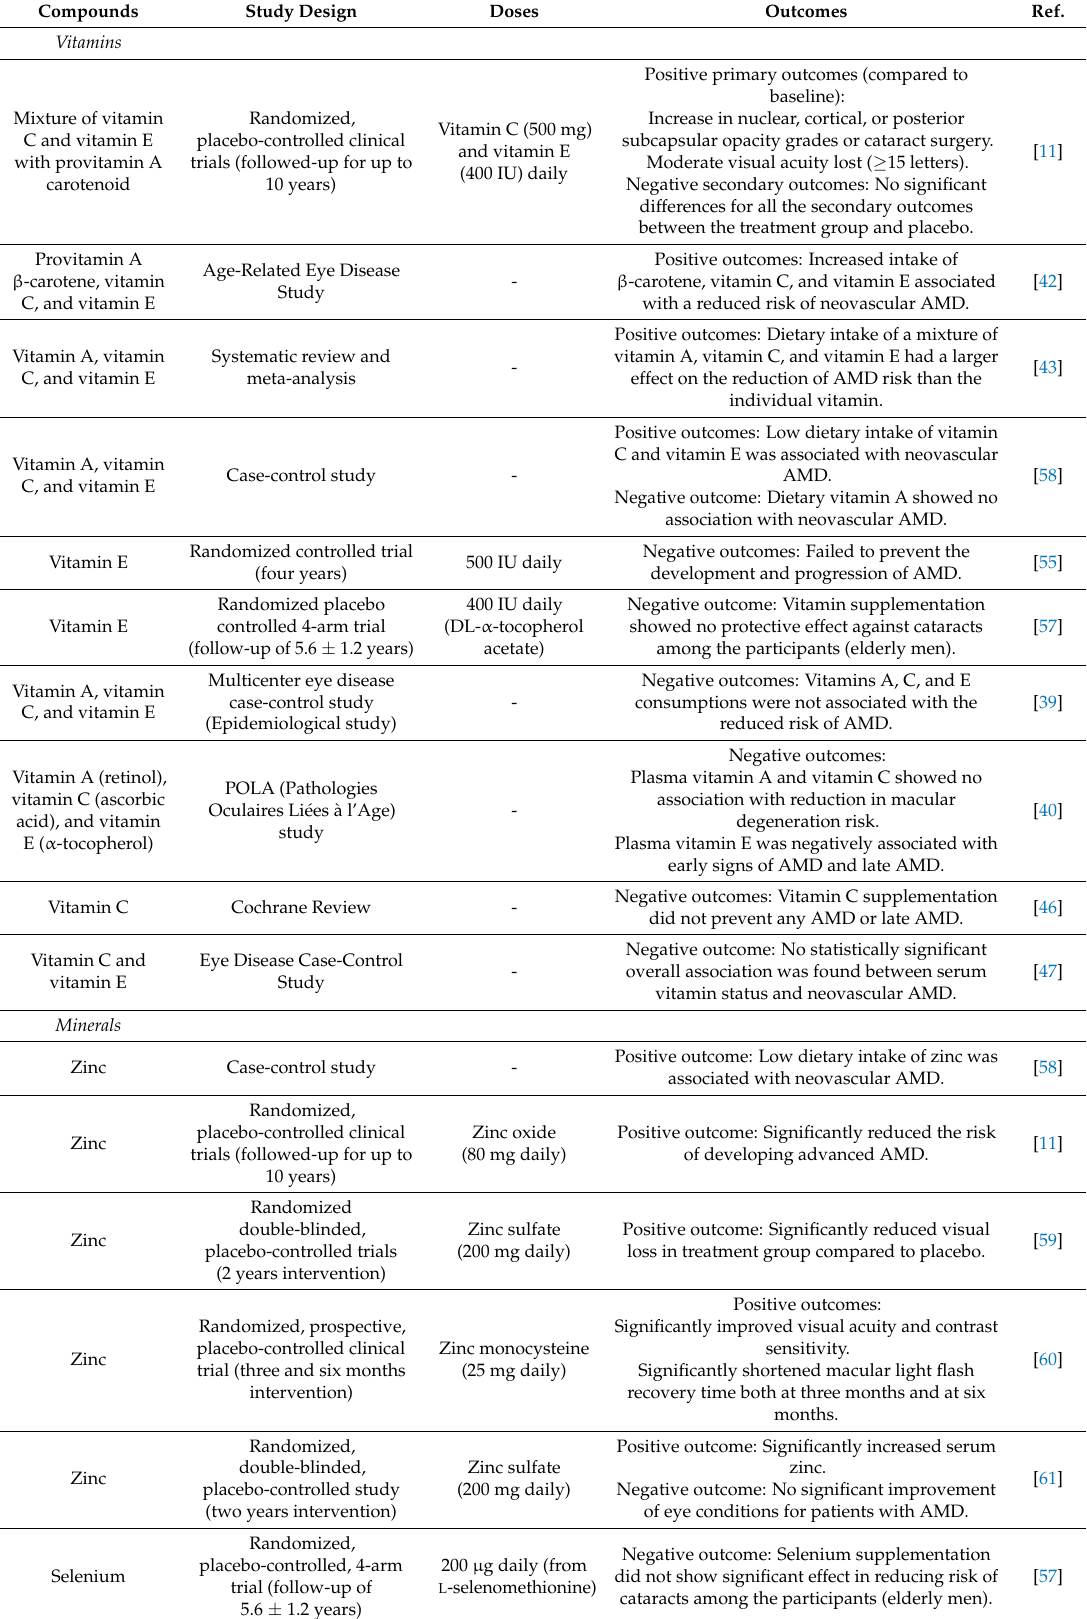
Table 2. Positive and negative outcomes of vitamins and minerals against age-related macular degeneration and eye-related